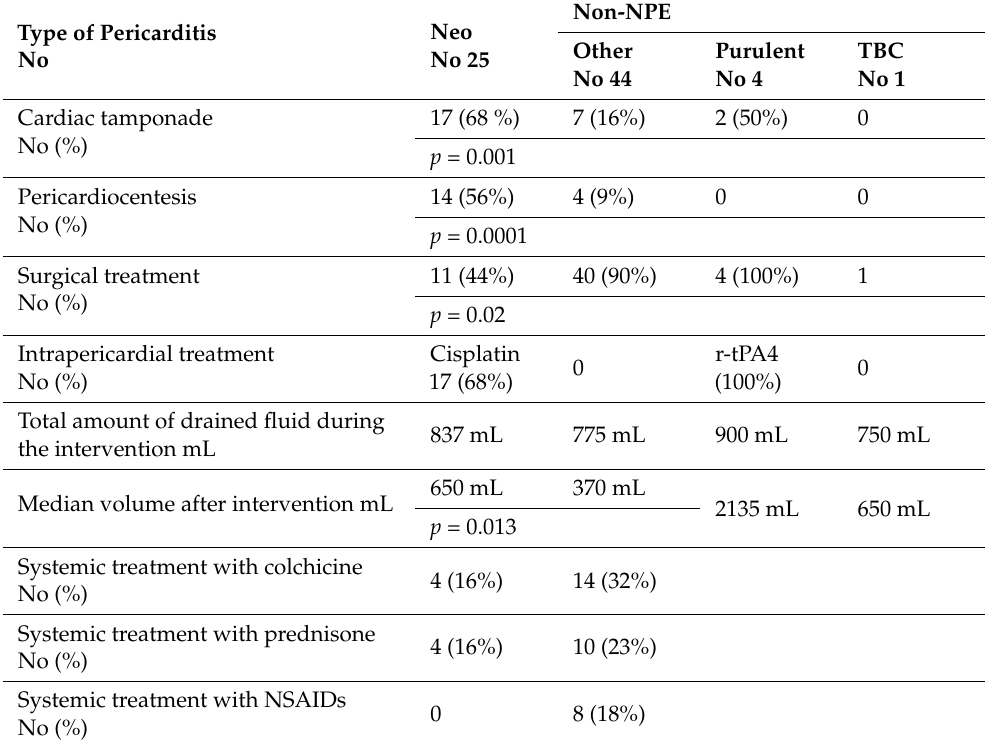
Table 1. Etiology, hemodynamic consequences, and applied treatment modalities in 74 with large pericardial effusion.